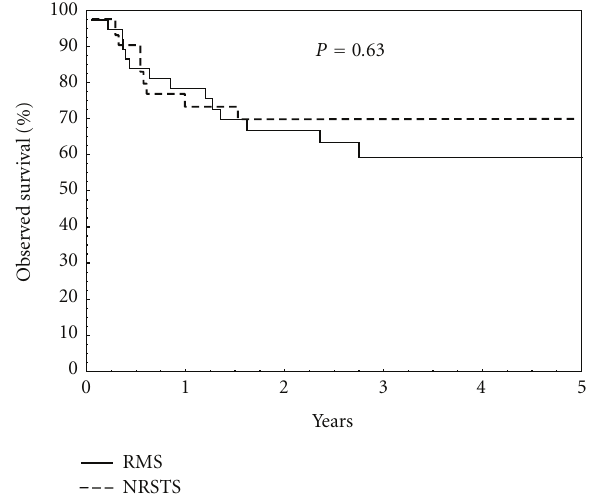
Figure 2: Observed survival, RMS versus NRSTS. OS for RMS